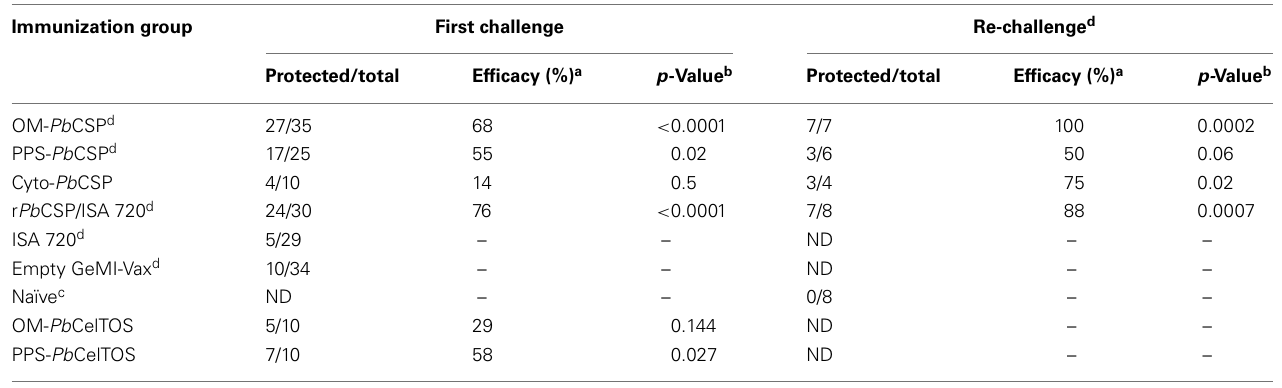
Table 2 | GeMI-Vax induce long-lasting protective immunity that varies by sub-cellular localization. Immunization